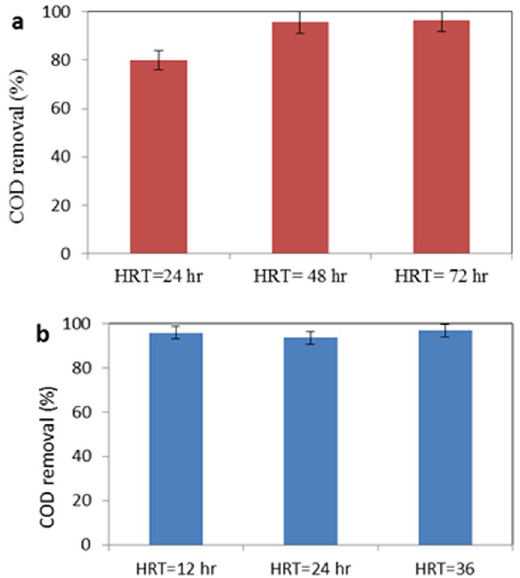
Figure 3. Determination of optimal HRT for anaerobic and aerobic units.